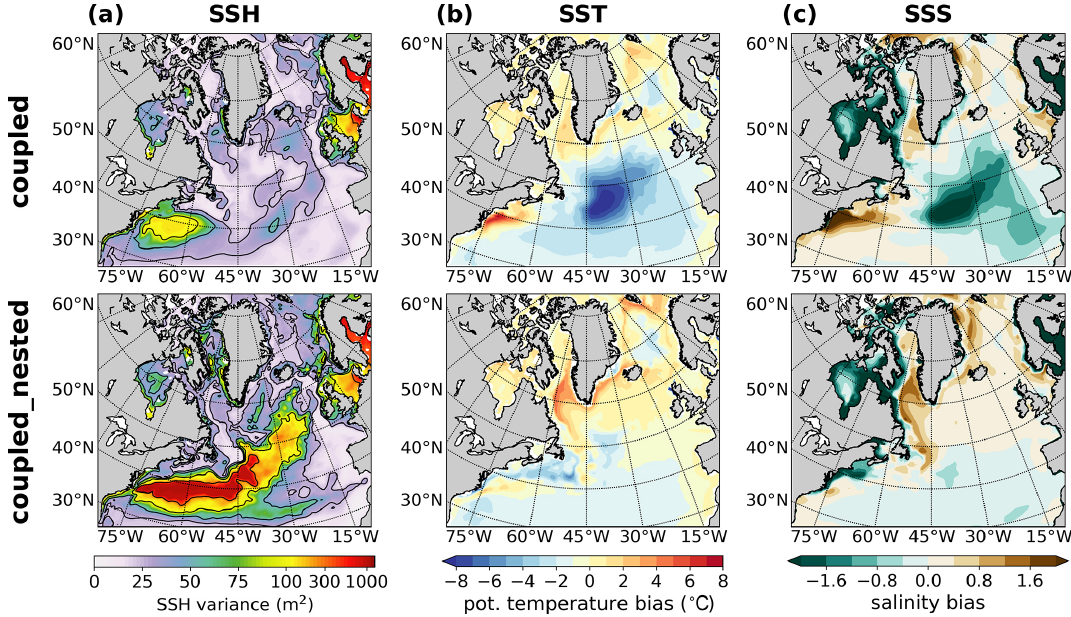
Figure 3. Examples of improvements by the regional-grid refinement from 1 / 2 ◦ (coupled) to 1 / 10 ◦ (coupled–nested): (a) enhanced mesoscale activity indicated by sea-surface-height (SSH) variance in 5d mean output, (b) reduced North Atlantic cold bias in sea-surface temperature (SST), and (c) improved representation of sea-surface salinity (SSS). All examples from the coupled-model experiments FOCI and FOCI-VIKING10 based on 50-year means. The SST and SSS biases are computed as difference from HadISST (Rayner, 2003), mean over 1870–1899 to compare with pre-industrial model experiments, and WOA98 climatological salinity (Levitus et al., 1998),